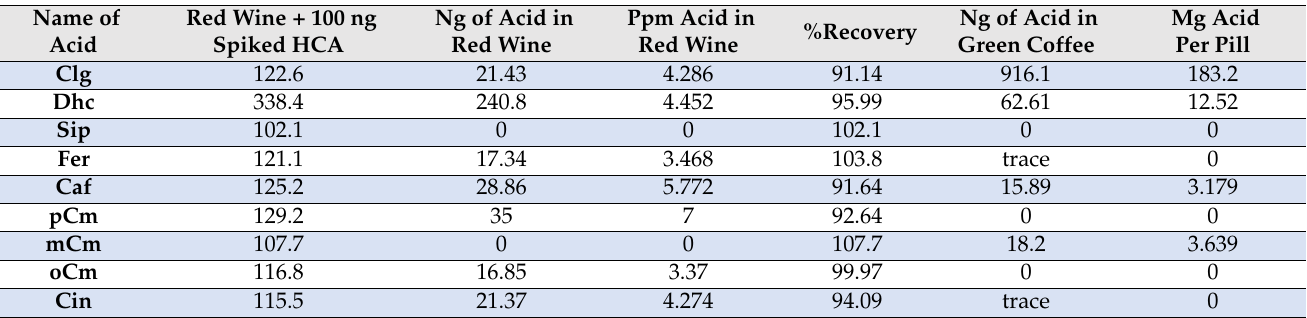
Table 8. The quantitative analysis of the organic red wine and green coffee diet pills. The recovery percentages were calculated by subtracting the amounts of the CA derivatives already found in the sample.